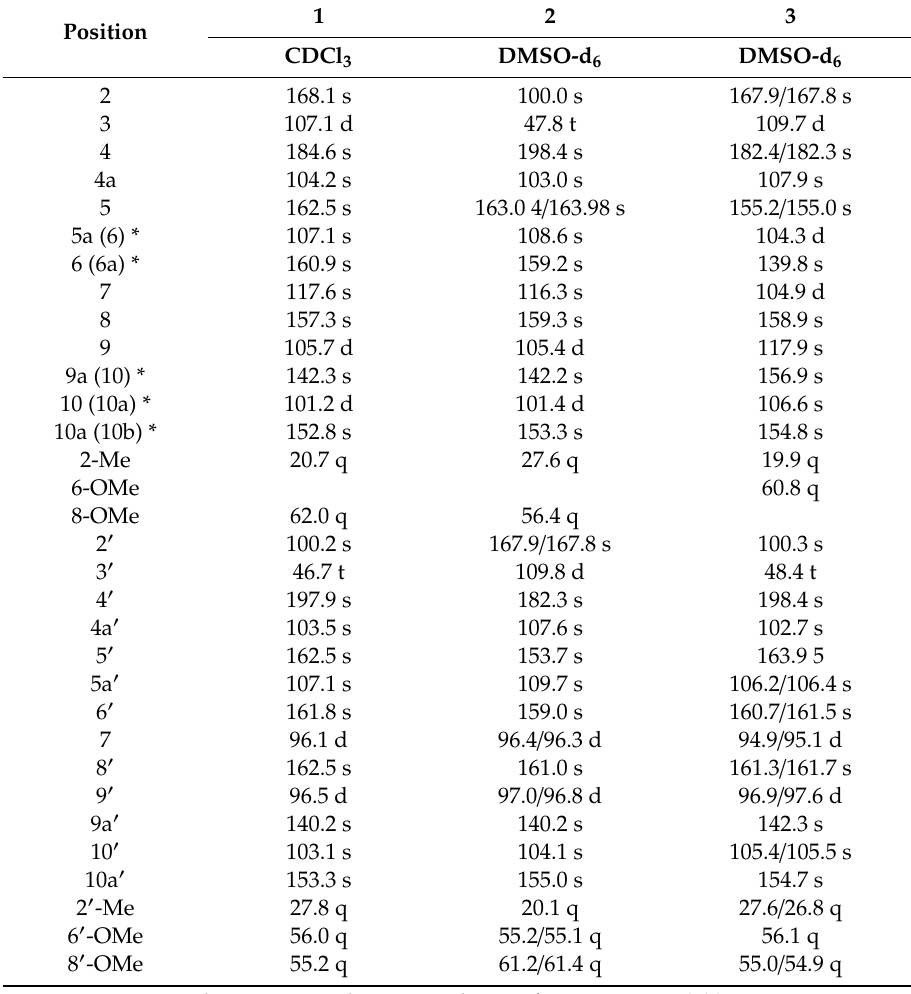
Table 1. 13 C NMR data (100 MHz, δ ) for teratopyrones A–C ( 1 – 3 ).